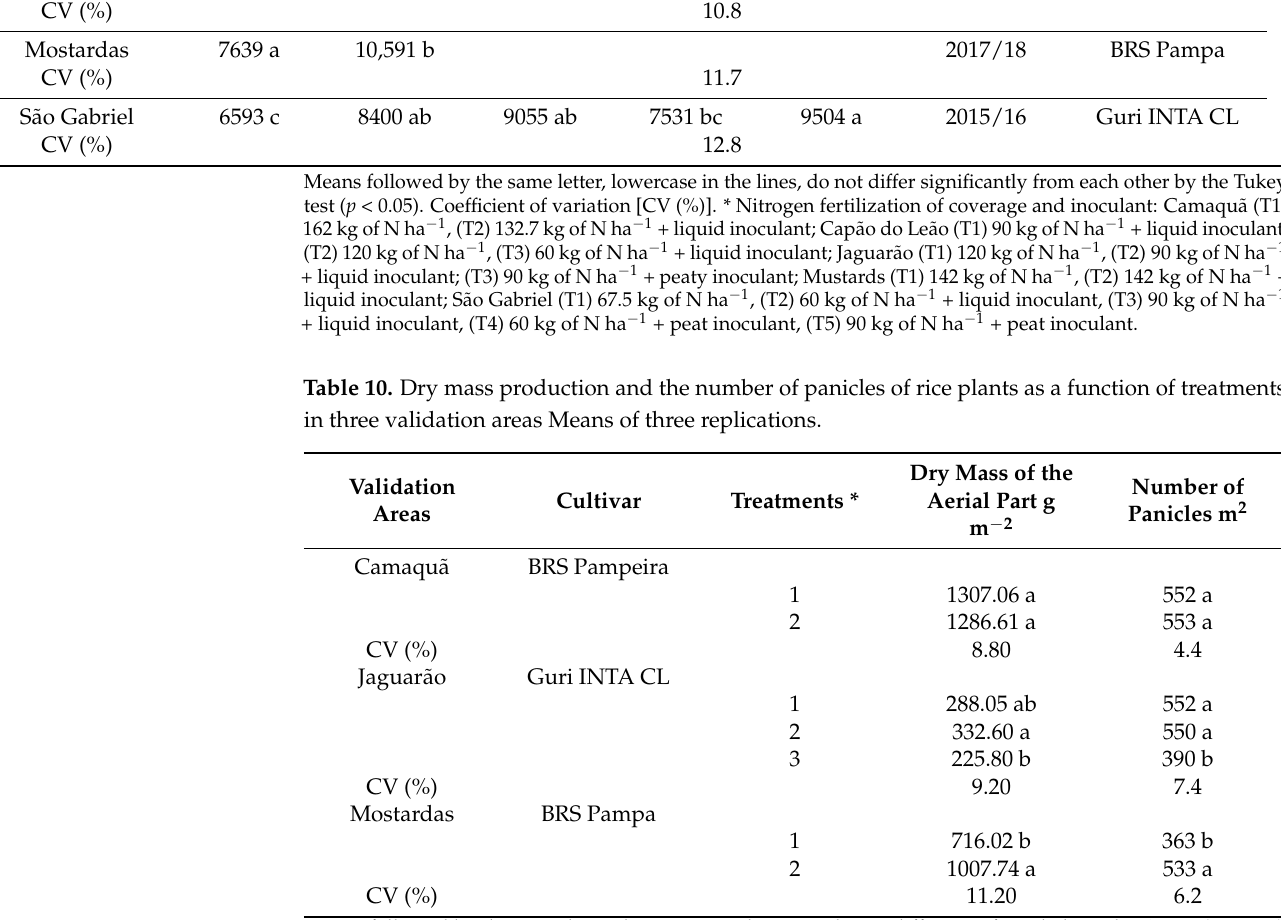
Means followed by the same letter, lowercase in the lines, do not differ significantly from each other by the Tukey test ( p < 0.05). Coefficient of variation [CV (%)]. * Nitrogen fertilization of coverage and inoculant: Camaqu ã (T1)